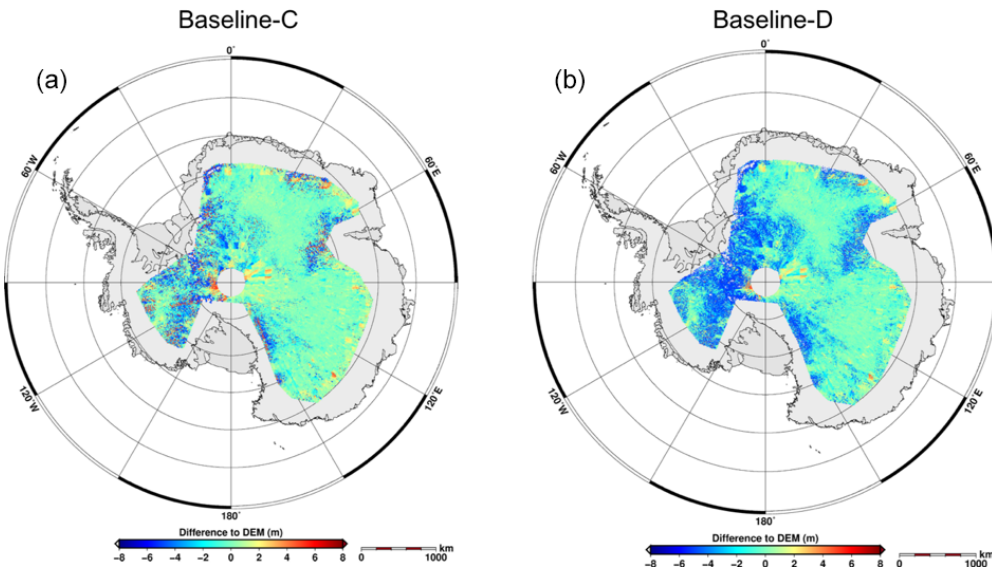
Figure 3. Differences in slope-corrected LRM data to reference DEM (REMA, Howat et al., 2019) in Antarctica. (a) Baseline-C REMA: +